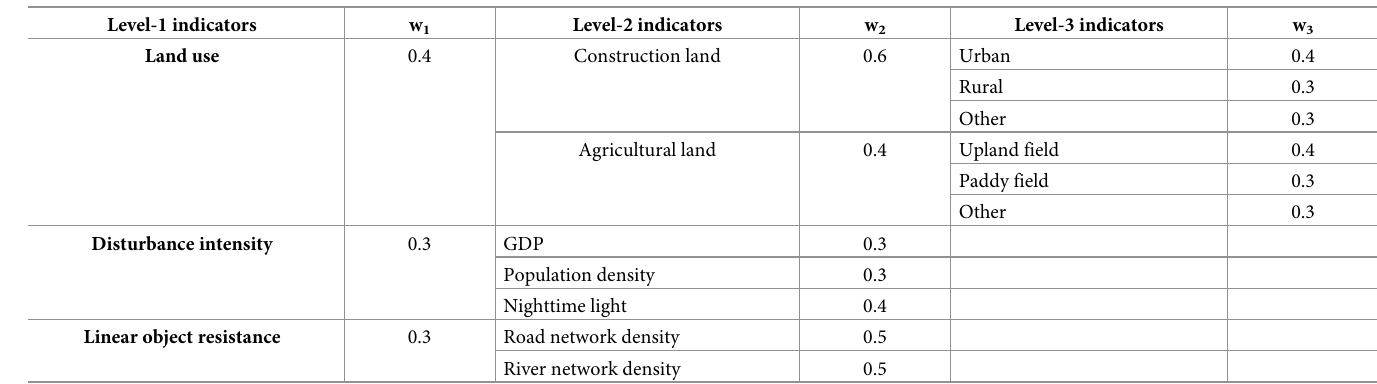
Table 1. Indicator system of resistance